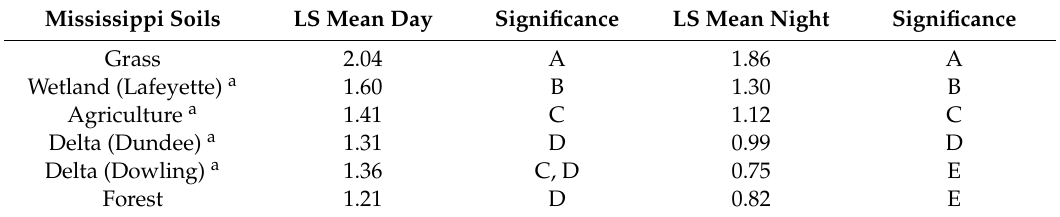
Table 5. Differences air/surface Hg fluxes (ng m − 2 h − 1 ) between landscapes during the summer. LS = least squares mean from analysis of covariance (ANCOVA). Soils not connected by the same letter are significantly different ( p < 0.05).